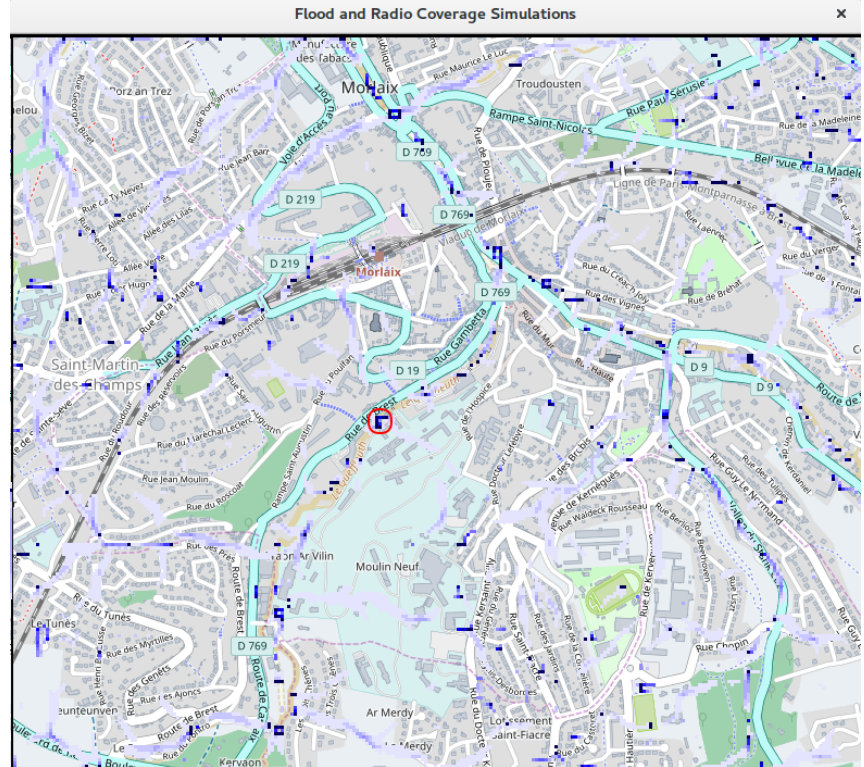
Figure A2. Simulation results for Morlaix, obtained by executing massively parallel processes on GPUs with thousands of CUDA cores. The experimental zone is comprised of 58,275 cells corresponding to actual area 3 × 3 km. A place of concern is indicated by a red circle. This is rue de Brest near the river Queffleuth (longitude: − 3.8329839706421, latitude: 48.573767695437, elevation: 10.1 m) where the water level went up to 60 cm according to Le Télégramme newspaper. The main flooding directions can be seen in light blue over the